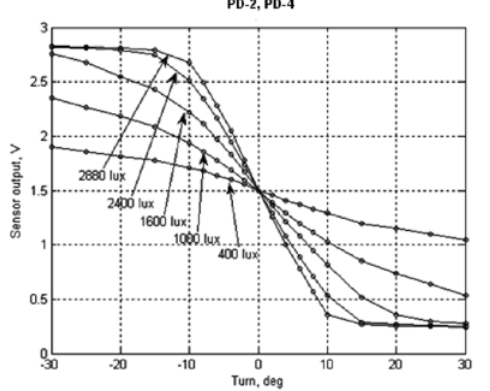
Fig. 12. Output characteristics of sensor unit